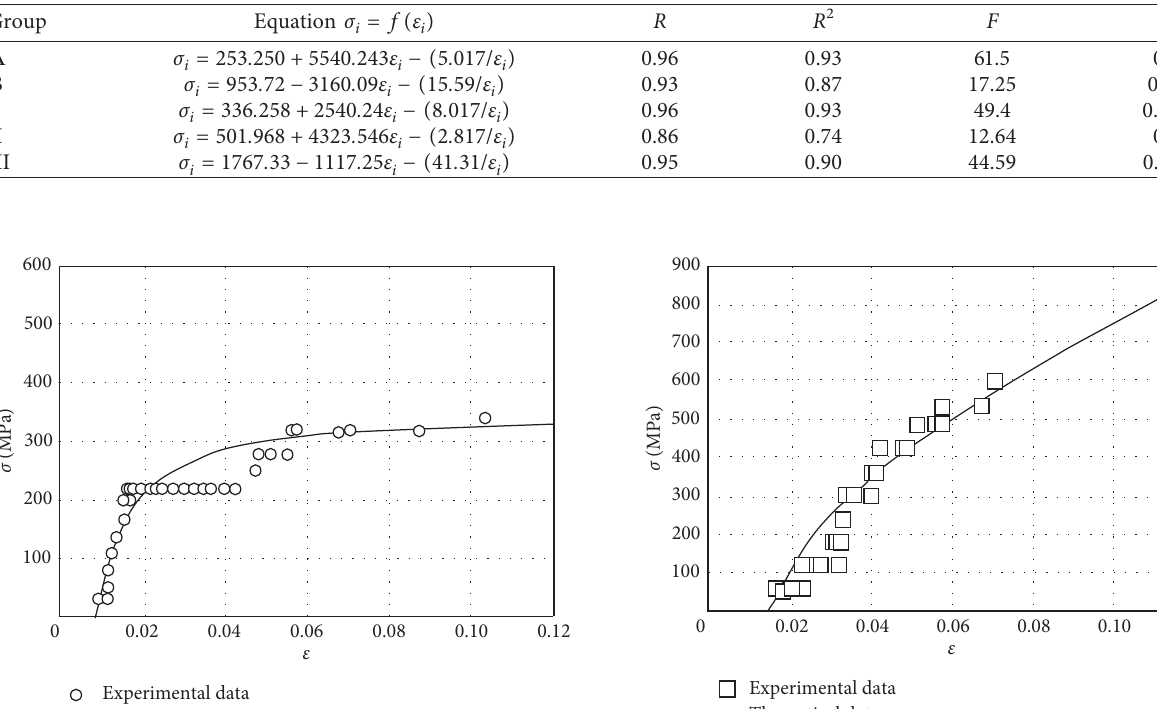
Table 14: Regression calculation results.